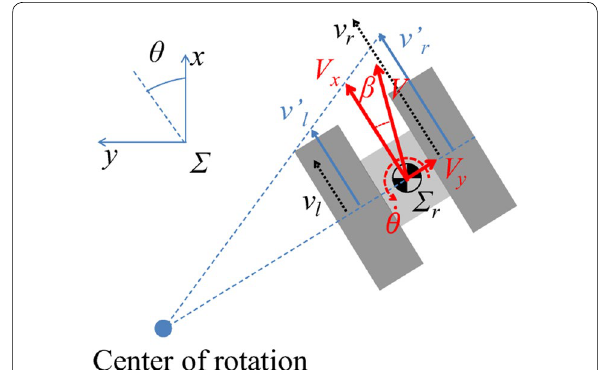
Fig. 1 Kinematics of a skid-steering tracked